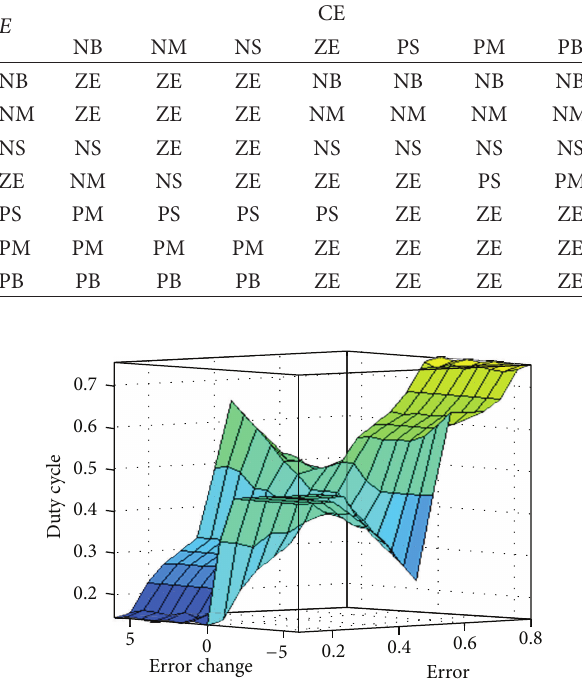
Table 1: The forty-nine fuzzy rules of the fuzzy system.